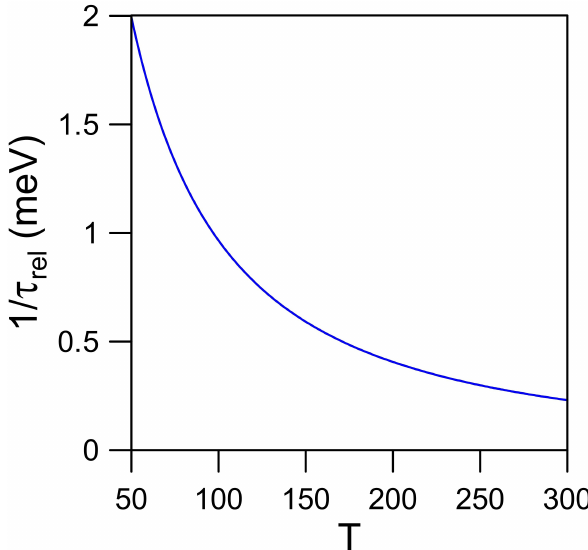
Figure 10. Calculated average energy-relaxation rate 1/ τ rel ( T ) from Equation (52) as a function of temperature T due to elastic scattering of doped electrons with impurities in graphene material, where (cid:101) r = 2.4, Γ e = Γ h = 0.01meV, Z ∗ = 1, doped electron areal density n 0 = 1 × 10 11 cm − 2 , and impurity areal density n im = n 0 are